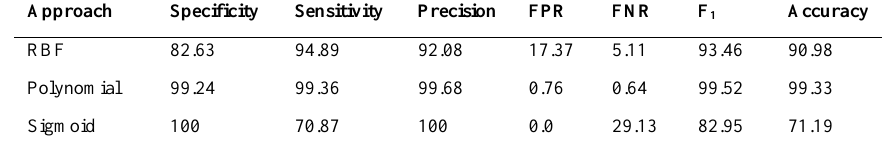
Figure 6. Performance of SVM with various approaches in training dataset. Table 6. Comparison of performance of SVM with RBF, polynomial, and sigmoid approaches on PD using testing data (%).